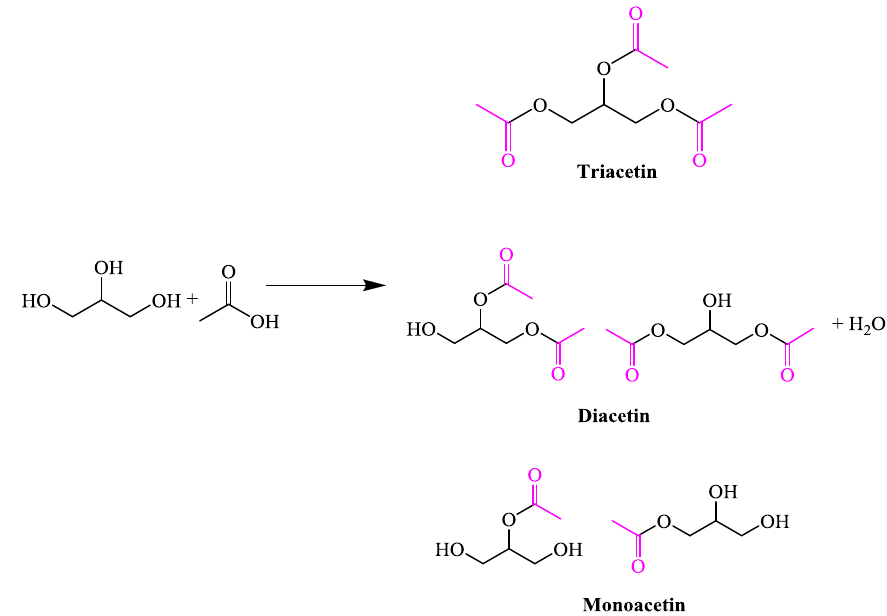
Figure 7. Glycerol esterification with acetic acid.